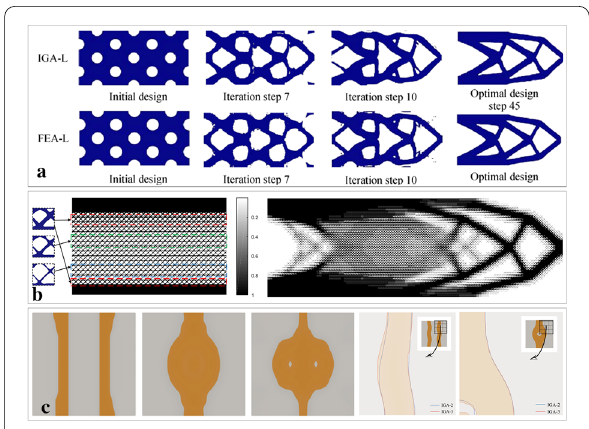
Figure 7 Some numerical results